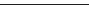
FIG. 11. Comparison of Rod 6 activity measurements using a HPGe and a well-type detector. Refer to the caption of Fig. 9 for details related to the